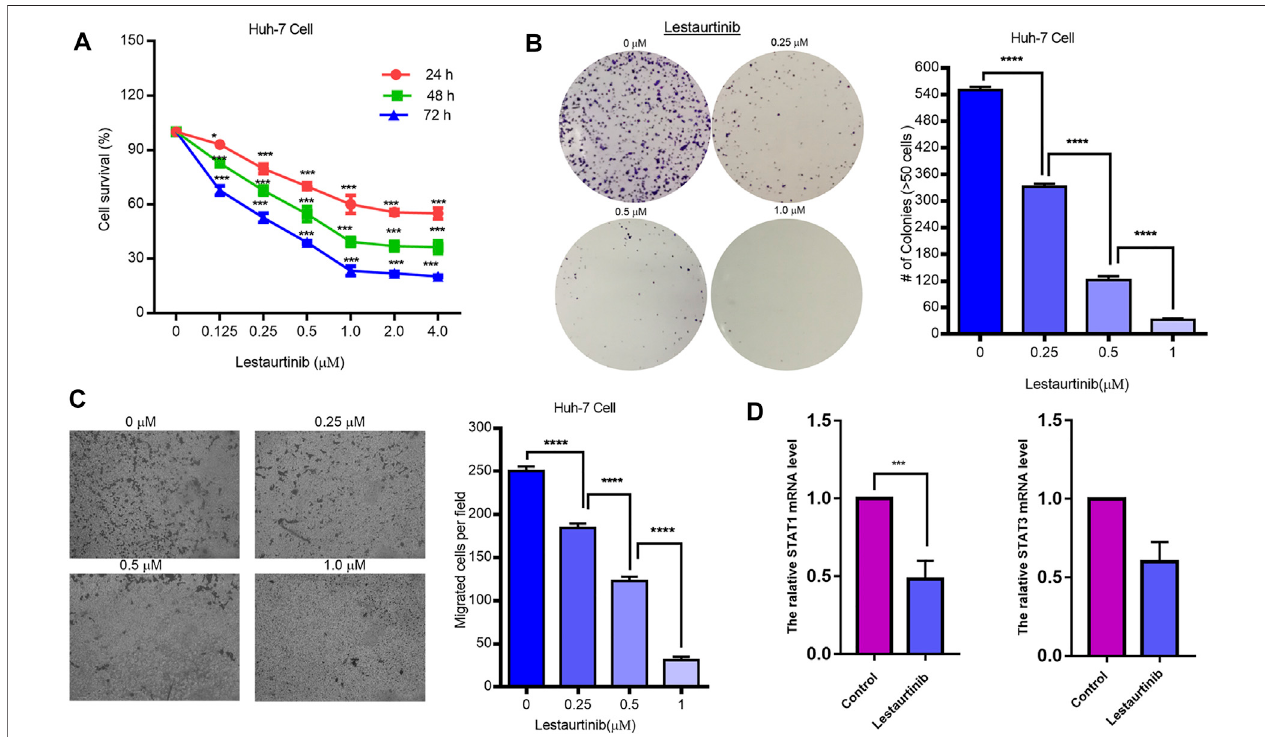
FIGURE 6 | Effects of the JAK2 inhibitor lestaurtinib on liver cancer cells. (A) MTT results of lestaurtinib in Huh-7 cells. (B) Colony formation and (C) transwell migration results of lestaurtinib on Huh-7 cells. (D) mRNA expression of STAT1 and STAT3. Data were obtained from three independent experiments. * p < 0.05, ** p < 0.01, and *** p < 0.001, compared with the control